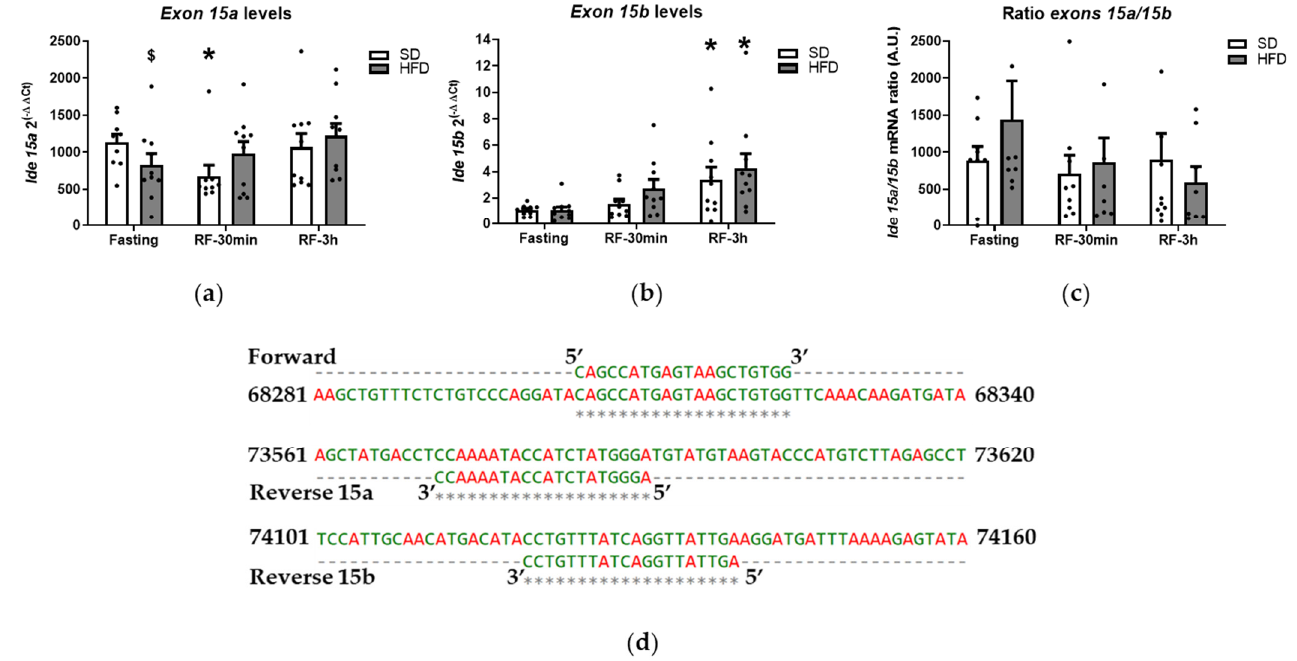
Cells 2021 , 10 , x Figure A3. Effects of feeding conditions on levels exons 15a and 15b of mouse Ide . ( a ) Levels of 15a Ide mRNA in the liver. ( b ) Levels of 15a Ide mRNA in the liver. ( c ) Ratio 15a/15b. Data are the means ± SEM. N = 9–10 mice per condition. * p < 0.05 vs. fasting by ANOVA. $ p < 0.05 vs. SD by ANOVA. ( d ) Alignment of forward and reverse primers to mouse Ide gene sequence (NC_000085.7:c37341664-37246140).